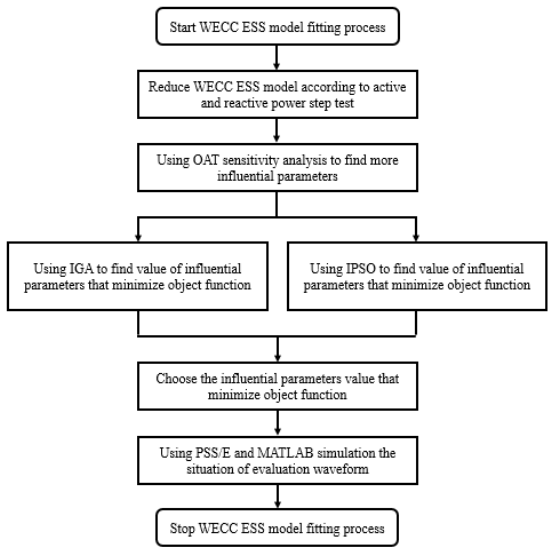
Figure 14. The flowchart for building the ESS WECC